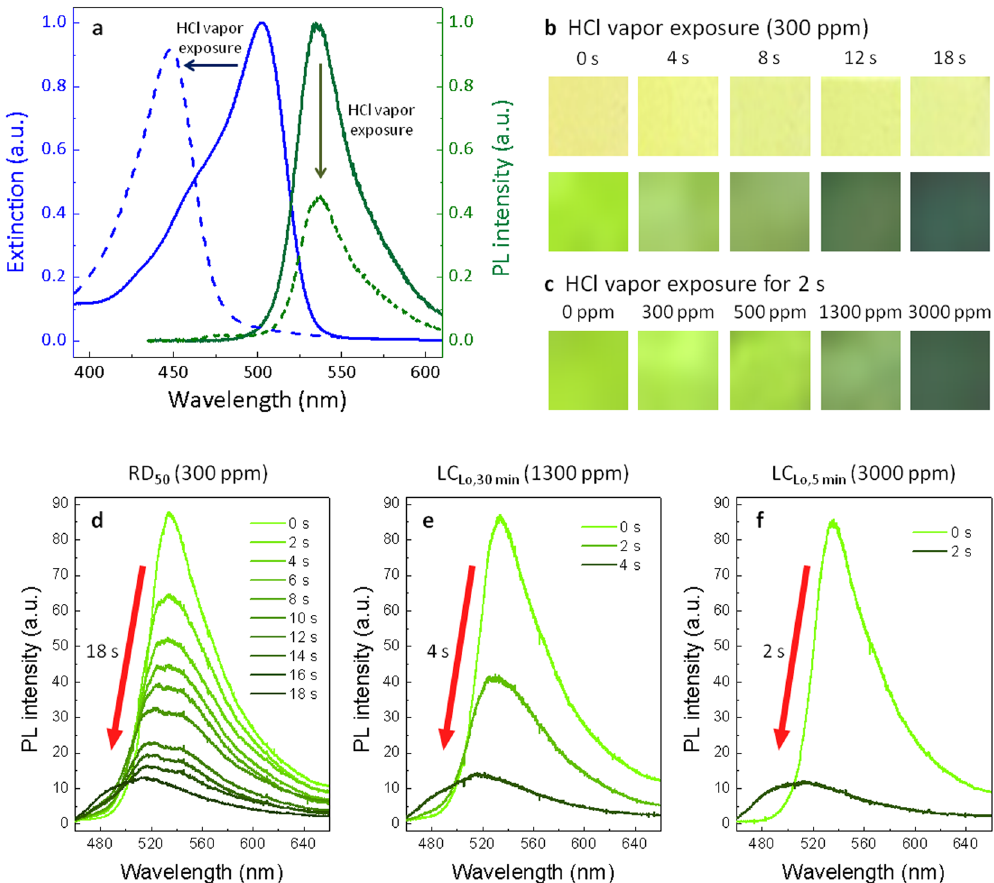
Figure 2. Results of the HCl vapor sensing experiment at lethal concentrations. ( a ) Absorption (blue line) and emission (green line) spectra of the sodium fluorescein-doped silk film before (solid) and after (dotted) exposure to HCl fume. ( b ) Time-dependent changes of external color and fluorescence of the FSNs exposed to 300 ppm HCl vapor. ( c ) Concentration-dependent fluorescence changes of FSNs exposed to HCl vapor for 2 seconds. Changes of photoluminescence spectra and response times of the FSN sensors in ( d ) 300 ppm, ( e ) 1300 ppm, and ( f ) 3000